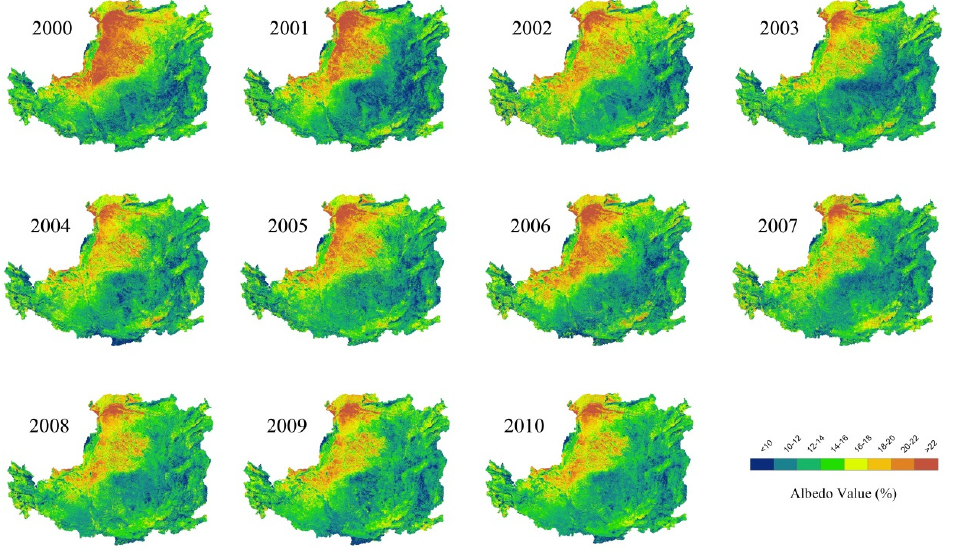
Figure 2. Peak season albedo (PSA) spatial and temporal distributions in the Loess Plateau from 2000 to 2010.